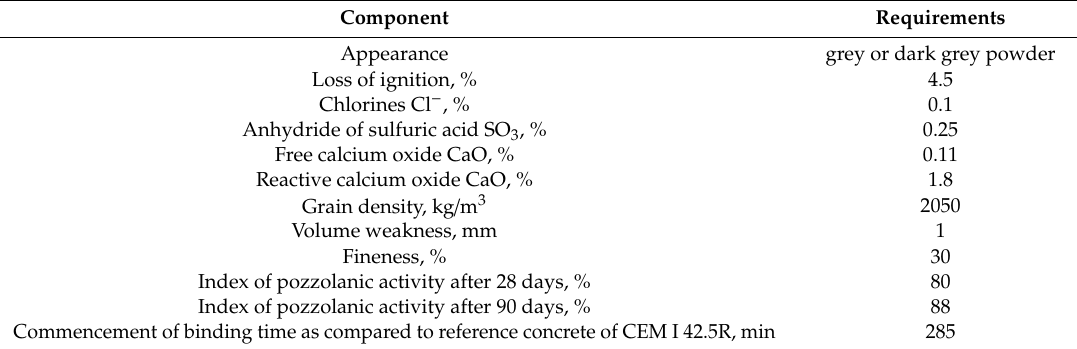
Table 5. Physical and chemical properties of fly ash [5].